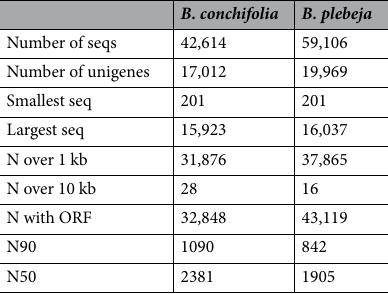
B. conchifolia B.